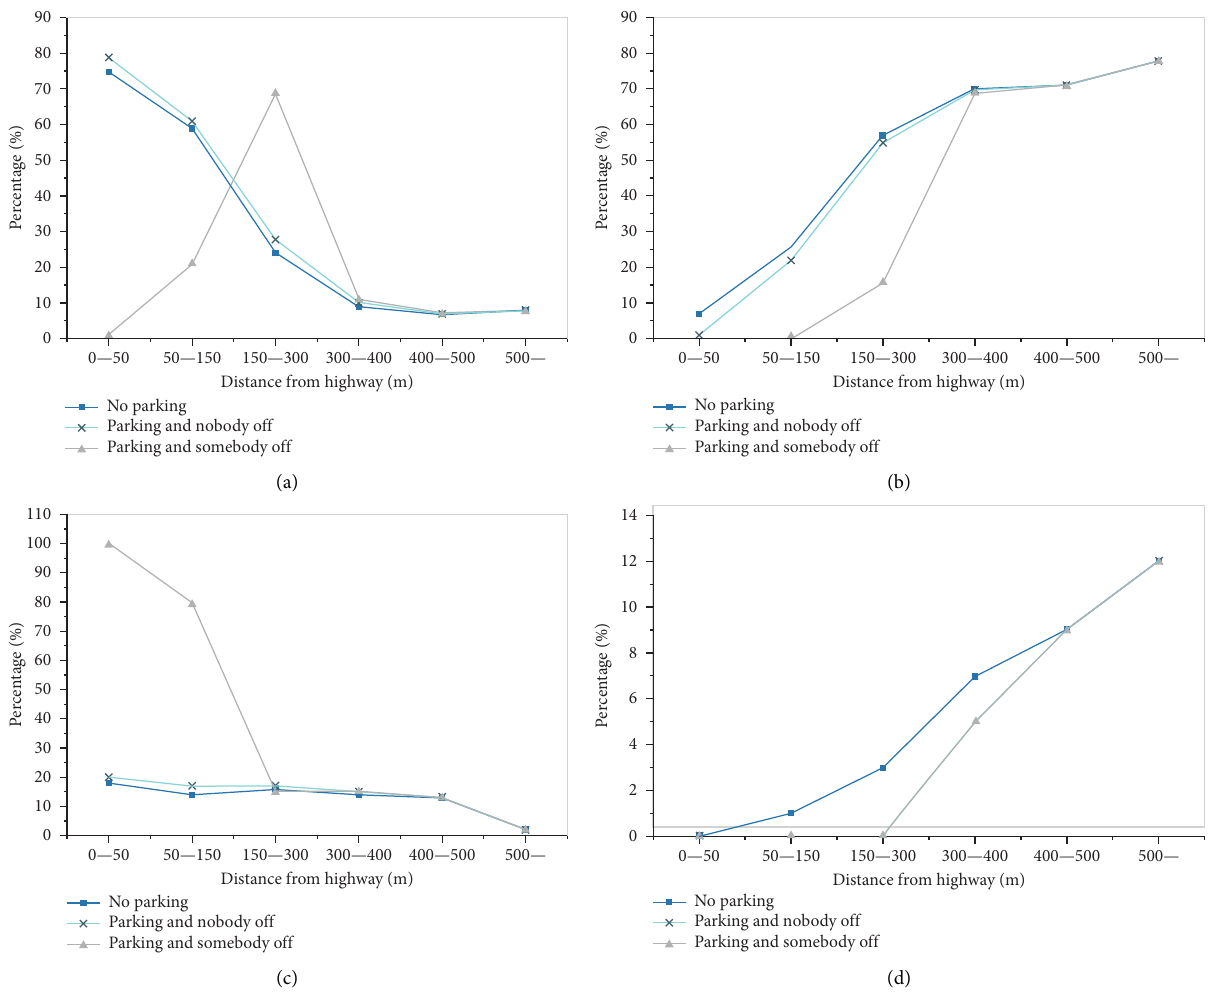
Figure 6: Changes in Tibetan antelope behavior with different parking behaviors. (a) Vigilance. (b) Foraging. (c) Movement. (d)